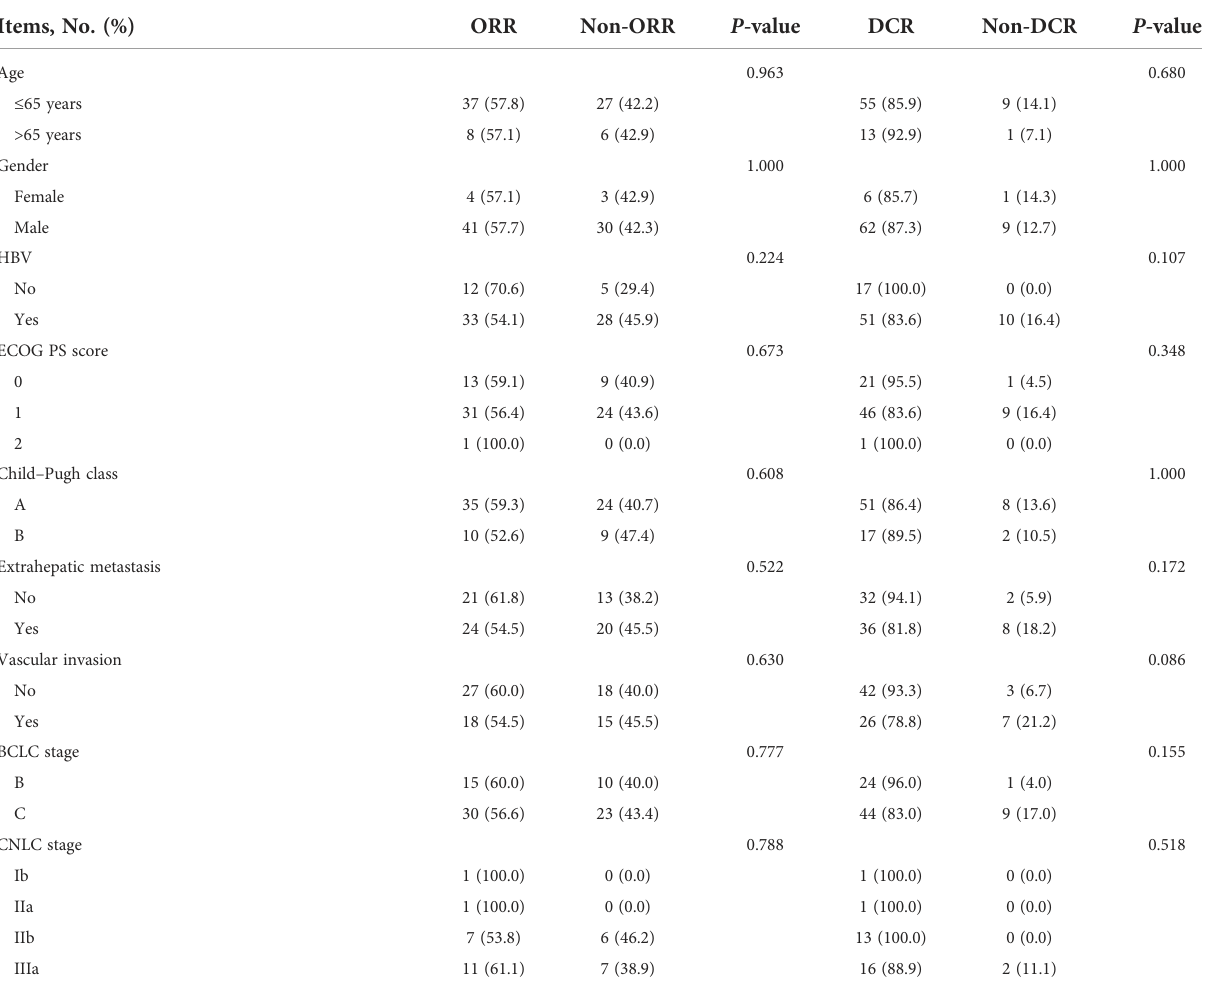
TABLE 2 Subgroup analysis of clinical